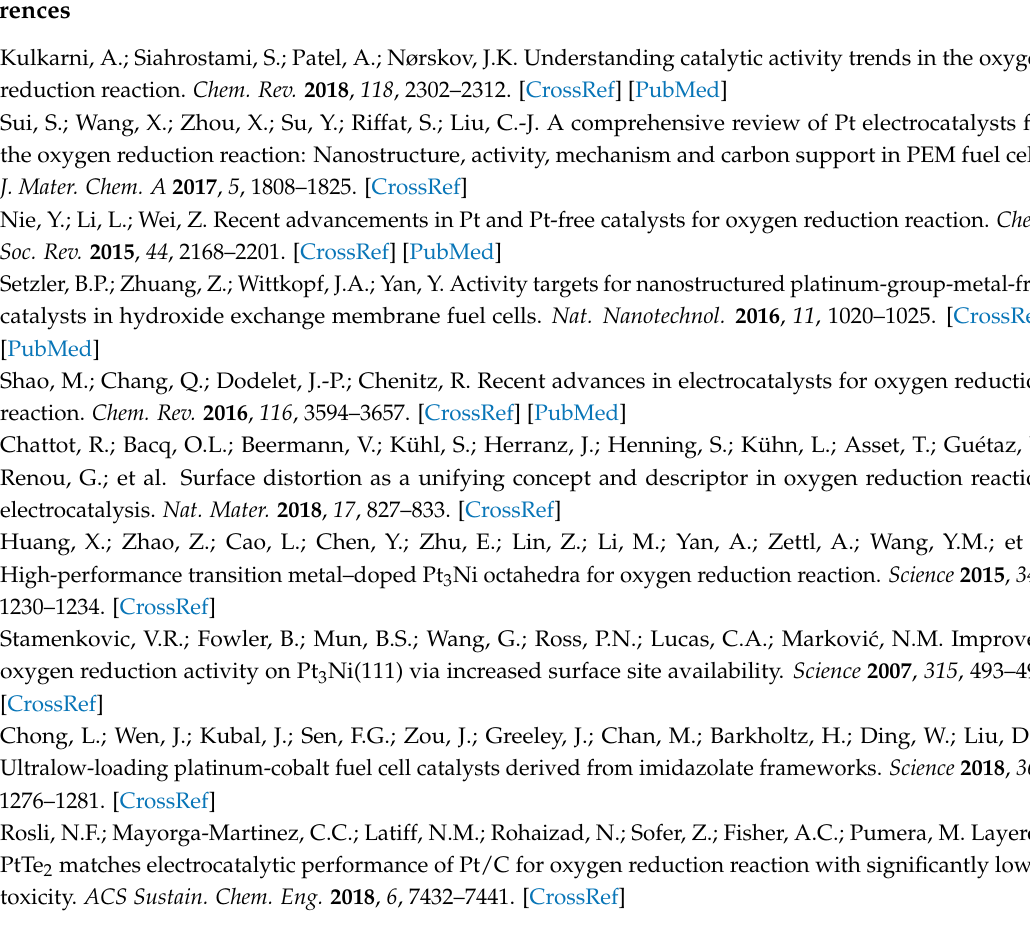
Figure S1: Linear combination fitting of the Fe k-edge XANES spectra of ICM-FePhen 3 -AW with Fe 3 C and Fe 0.5 NC as